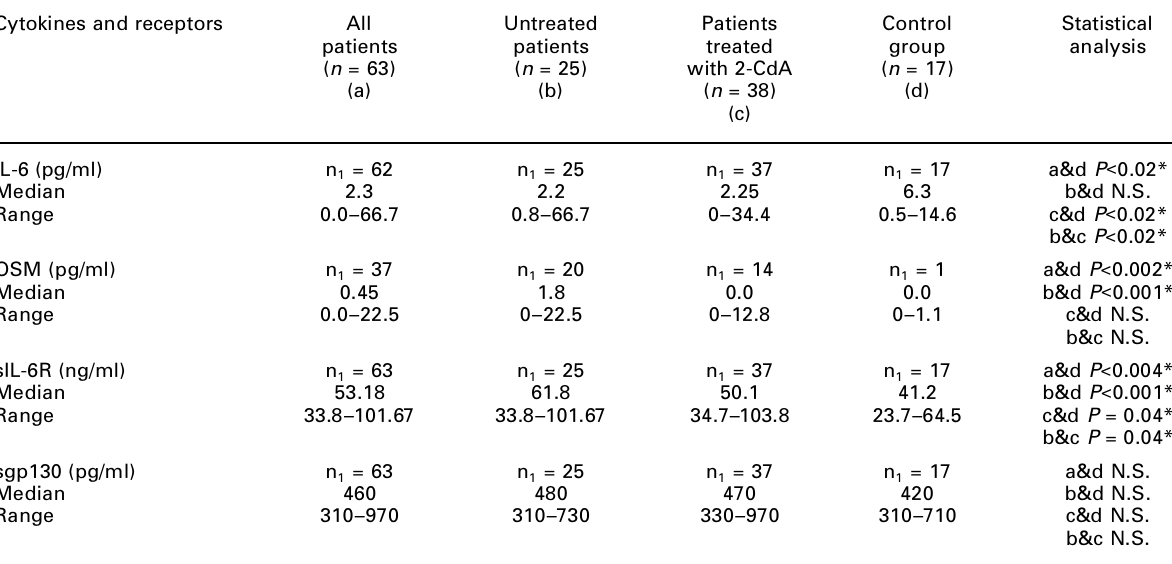
Table 2. Serum levels of IL-6, OSM, sIL-6R and sgp130 in untreated patients with CLL, patients treated with 2-CdA and normal control group. Median and range in parentheses Cytokines and